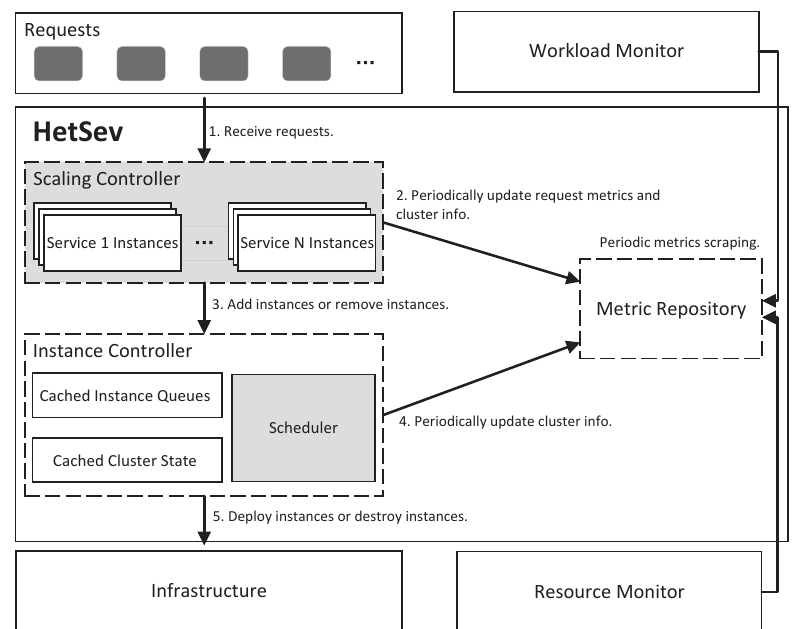
Figure 4. HetSev architecture. The boxes with dashed borders are the three main components of HetSev. The gray boxes are the controller-specific components which were re-implemented in our approach and deployed within a cluster manager (e.g., Kubernetes). The numbered arrows correspond to the typical workflow of